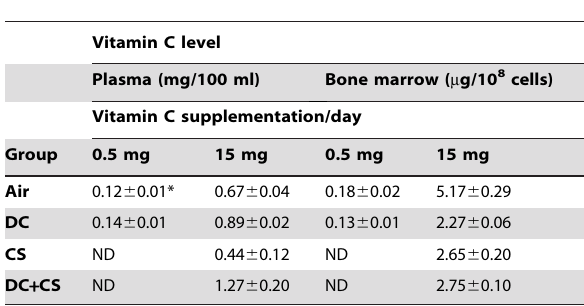
Table 1. Vitamin C levels in the plasma and bone marrow of guinea pigs fed 0.5 mg/day and 15 mg/day vitamin C for 21 days and exposed to air or